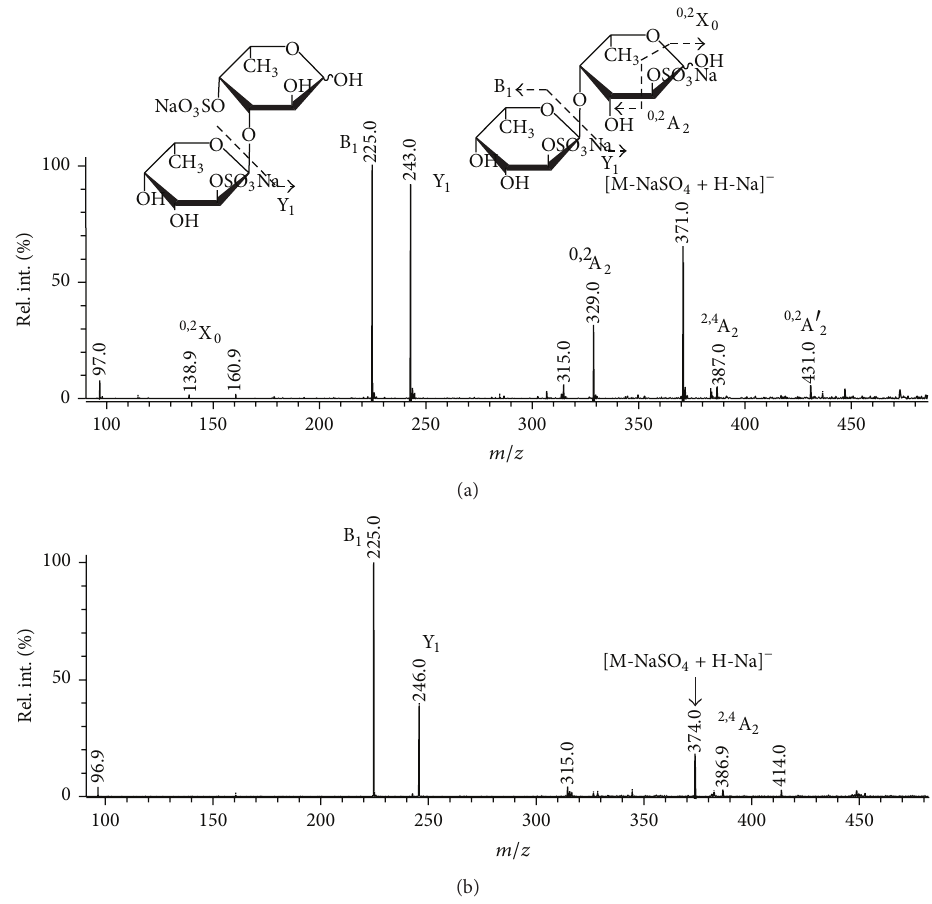
Figure 2: Negative-ion tandem MALDI-TOFMS ion at m/z 491.02. M represents sodium salt of oligosaccharide.